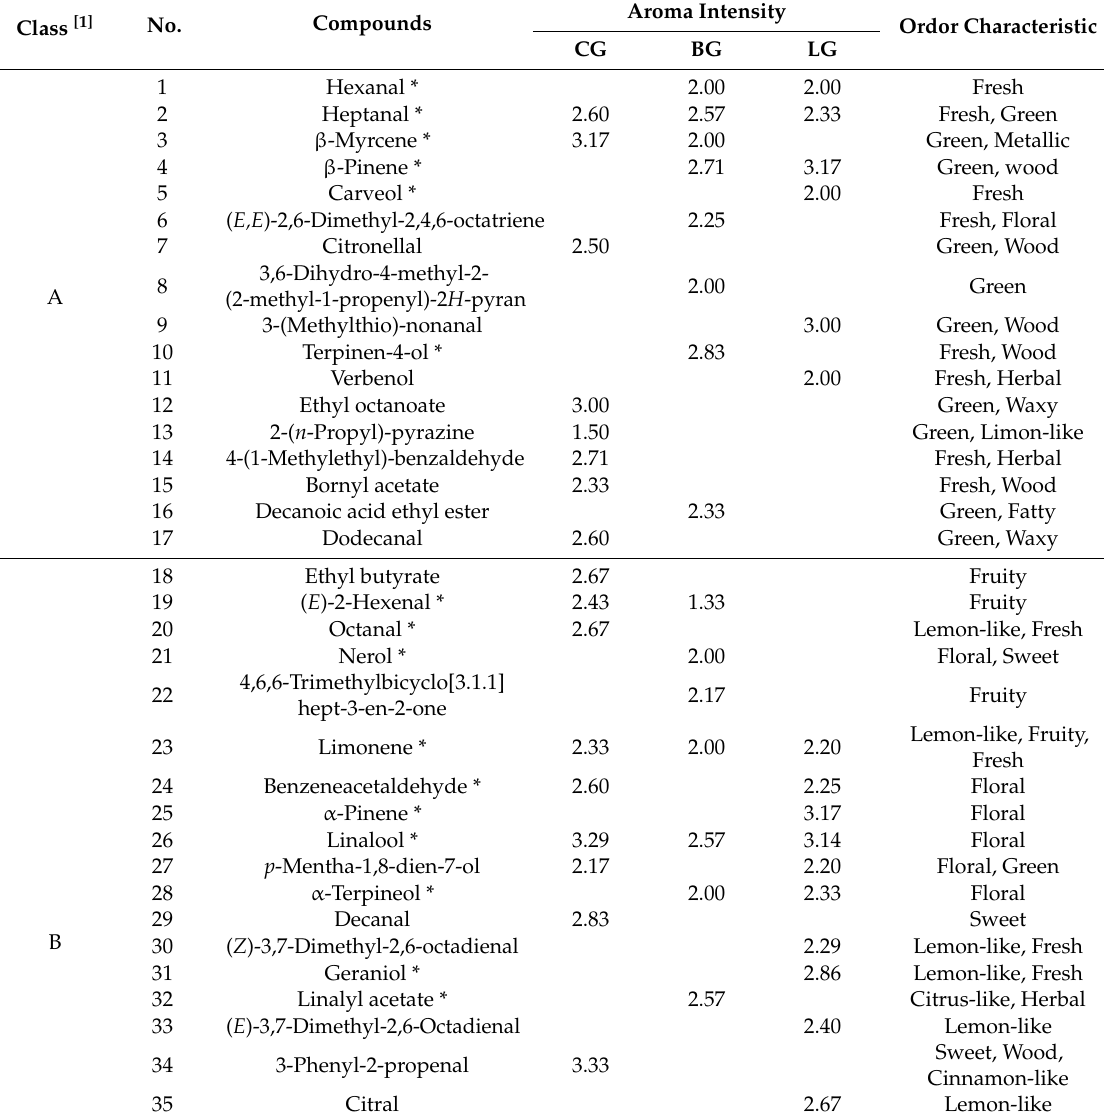
Table 2. Active aromatic compounds identified in citrus blend black